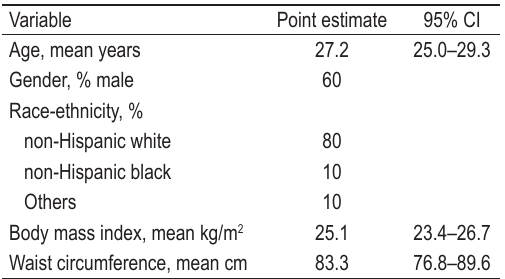
TABLE 1. Demographic characteristics of the analyzed